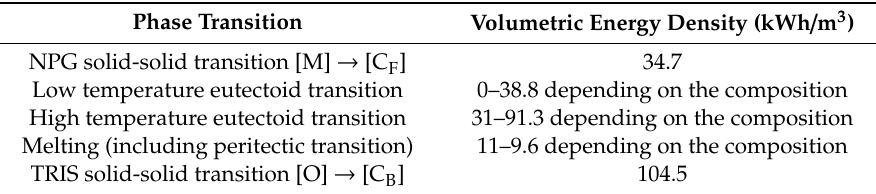
Table 5. Estimated volumetric energy density associated to the di ff erent phase transitions in NPG-TRIS